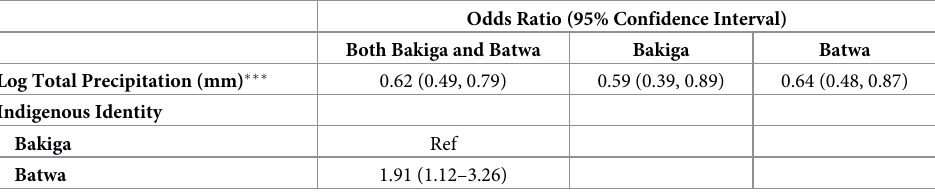
Table 2. Multivariable multi-level logistic regression models with random intercepts to control for community- level clustering of AGI and associated factors in 10 communities. � Models are presented with Indigenous identity as a fixed effect as well as stratified by Indigenous identity ��